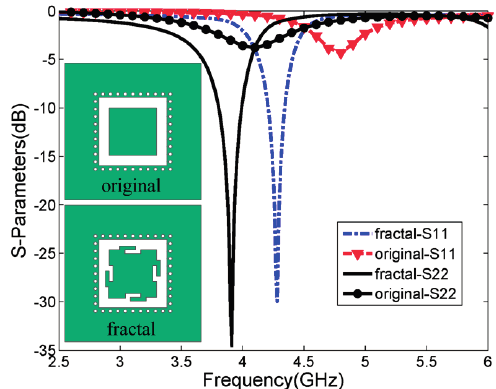
Figure 3. Simulated return loss with different radiator shapes.